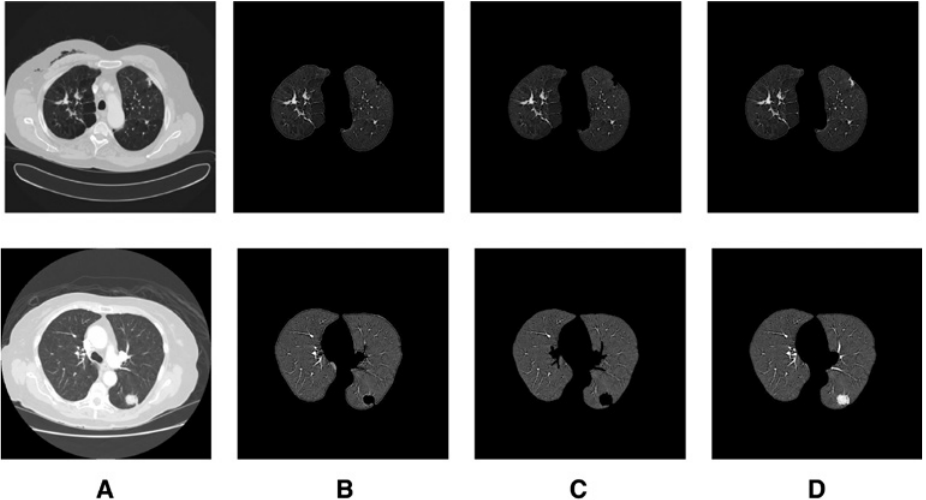
Figure 4: Comparison of segmentation results.